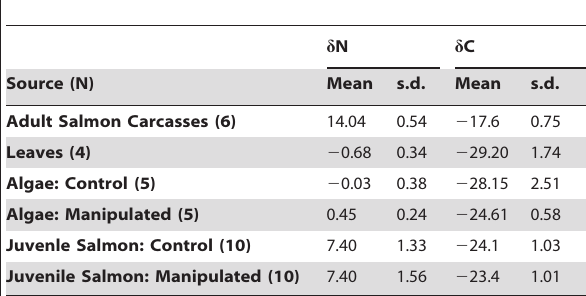
Table 2. Stable isotope ratios of nitrogen ( 15 N/ 14 N) and carbon ( 13 C/ 12 C) in tissues of potential food web energy sources, and of juvenile salmonids from different riparian zone